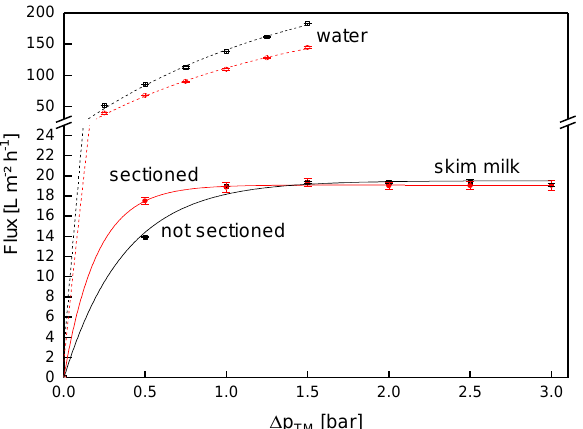
Figure 8. Flux as a function of the transmembrane pressure ( ∆ p TM ) for the sectioned and a non-sectioned SWM (length of 0.96 m) during filtration of water and skim milk at a mean crossflow velocity of 0.42 m s − 1 .